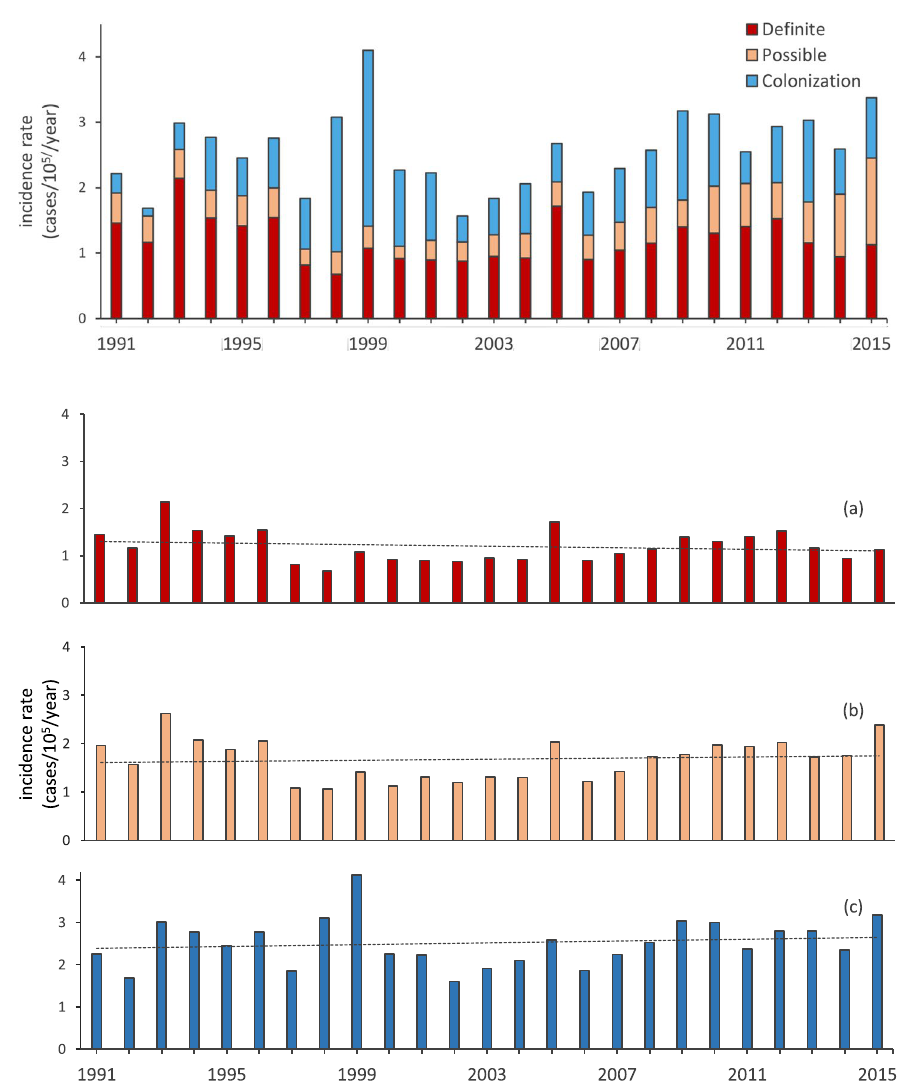
Figure 1. Annual incidence rates of definite NTM disease, possible NTM disease and NTM colonization. ( a ) Annual incidence rates of definite NTM disease, ( b ) annual incidence rates of definite and possible NTM disease and ( c ) annual incidence rates of total number of patients with a positive NTM culture. Quasi-Poisson generalized linear model found no trend towards an increase or decrease in the study period for definite NTM disease incidence ( a , p = 0.674), definite and possible NTM disease incidence ( b , p = 0.275) and patients with a positive NTM culture ( c , p =